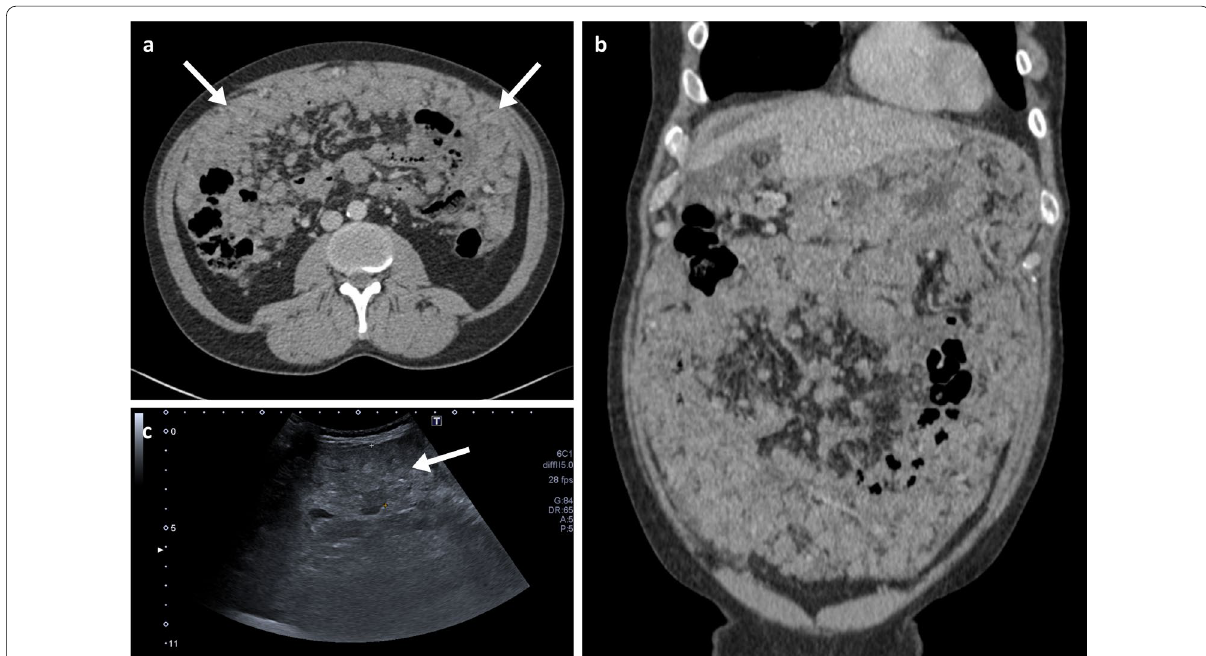
Fig. 16 Portal phase contrast-enhanced CT axial ( a ) and coronal ( b ), and abdominal ultrasound ( c ) of a 48-year-old male patient with extensive metastatic melanoma peritoneal disease with innumerable nodules and omental cake